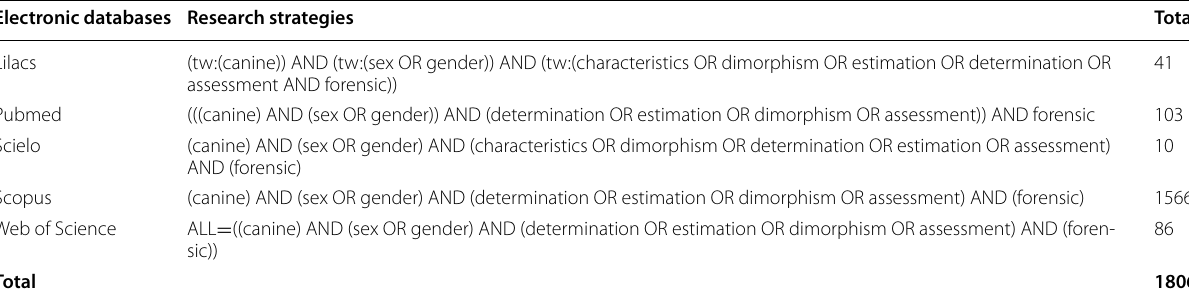
Table 1 Quantity of articles found in each database according to the search strategy Electronic databases Research strategies